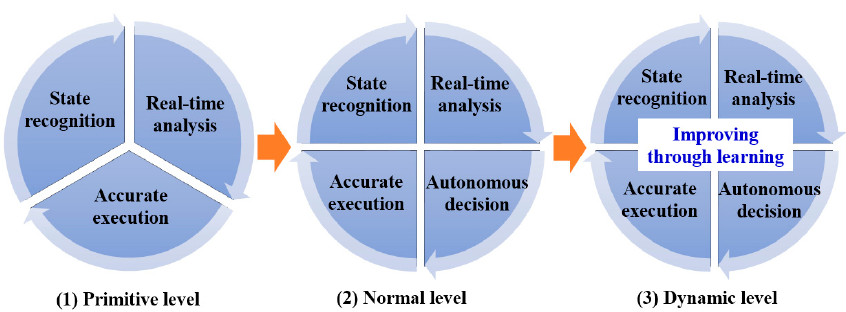
Figure 1. Three levels of intelligence in intelligent systems.